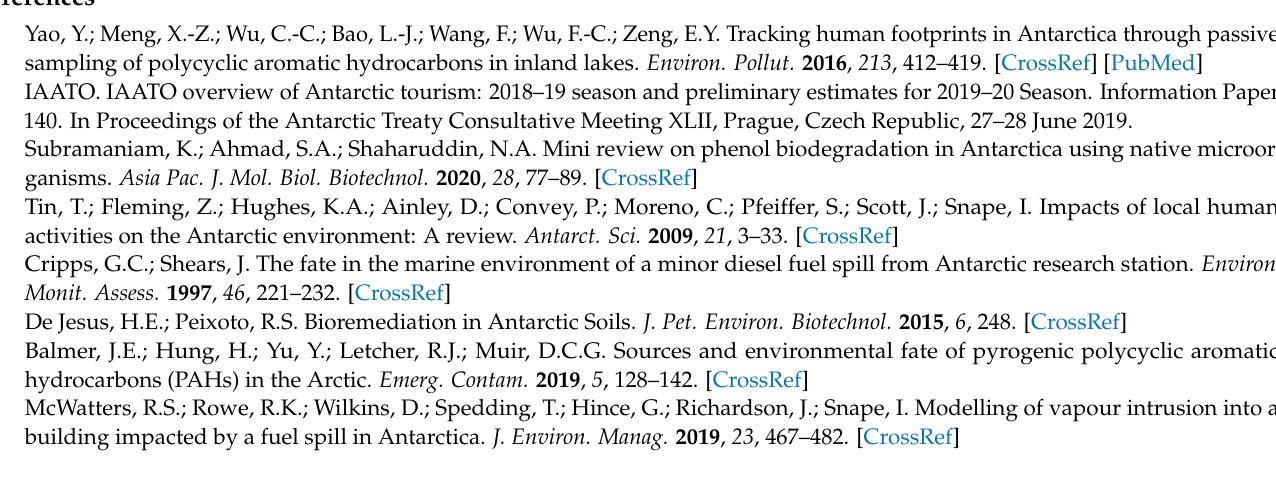
consortia. Figure S1. The growth curves of six selected soil consortia over 7-day incubation time. Error bars represent the mean ± standard deviation for experimental